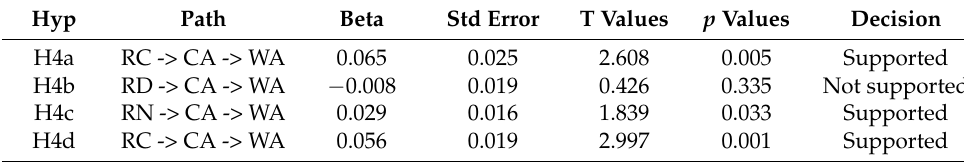
Table 11. Mediation Hypotheses Results.